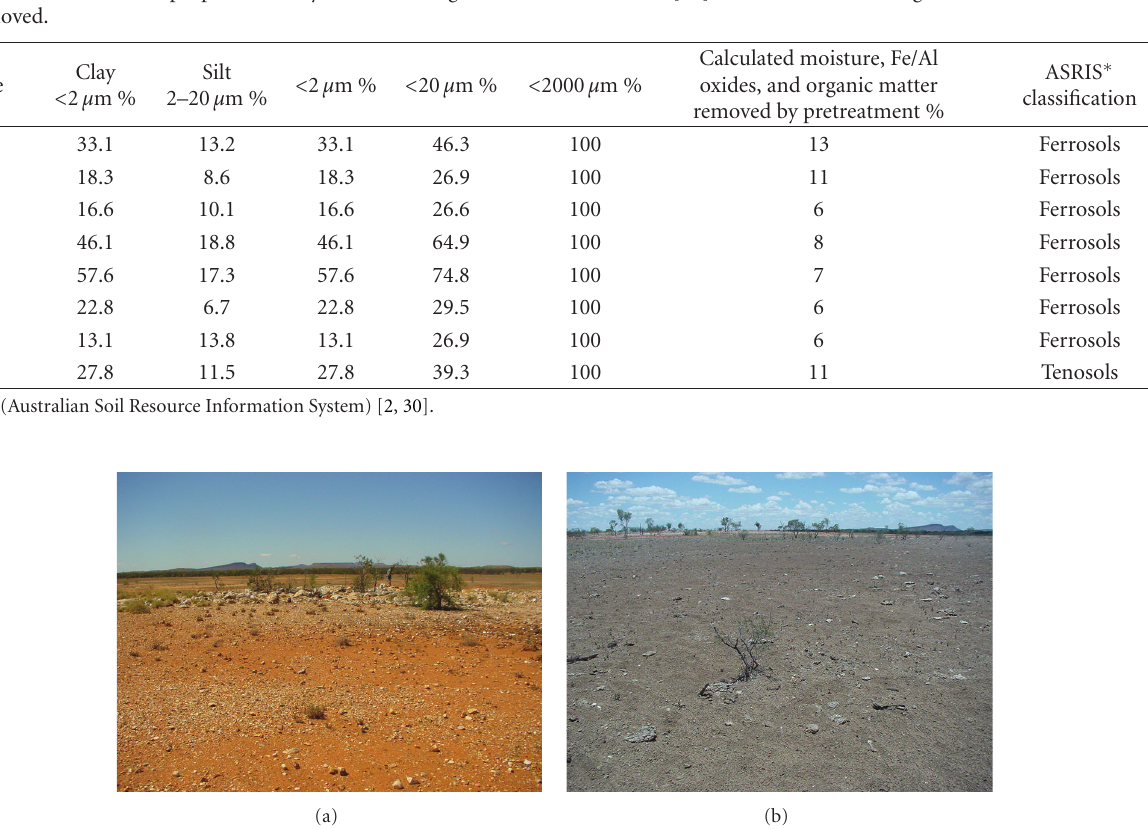
Figure 1: Example of the Tick Hill landscape for sample sites: (a) MI121 and (b) MI124.